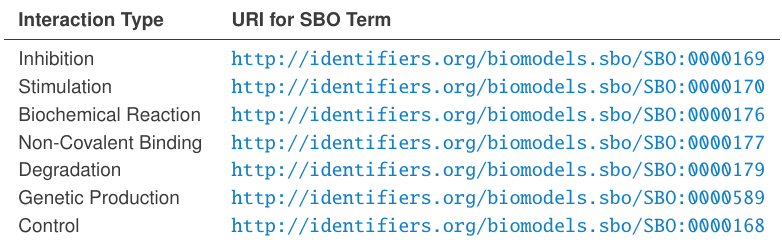
Table 10: Partial list of SBO terms to specify the type property of an Interaction .